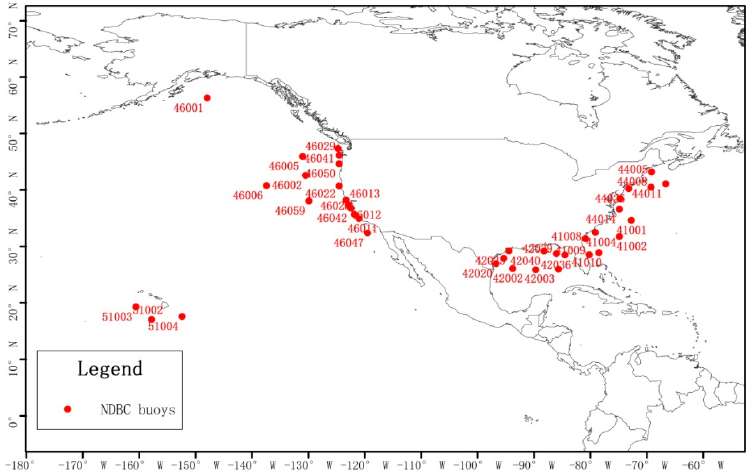
Figure 1. Location of National Data Buoy Center (NDBC) buoys providing hourly wind vector measurements used for comparison with satellite data.